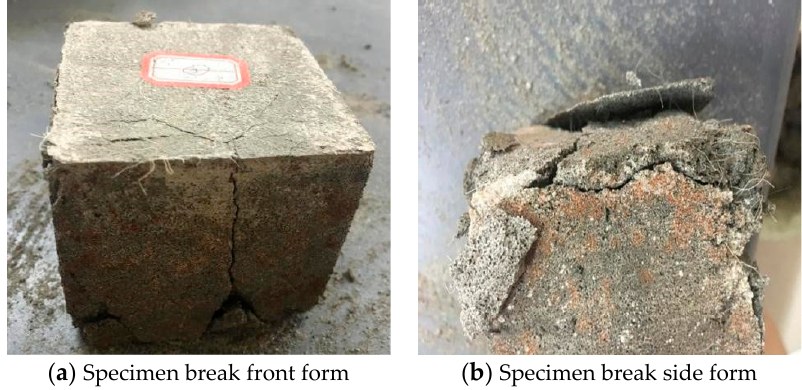
Figure 2. Specimen damage form.